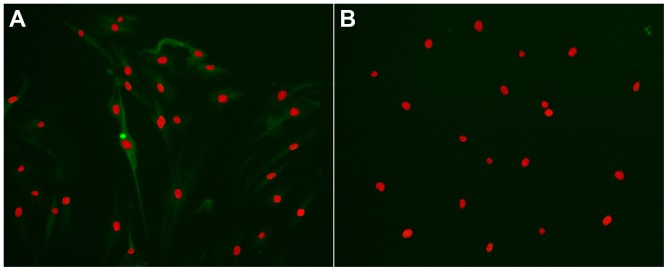
Immunofluorescence identification of human Tenon fibroblasts.Cells were identified by immunofluorescence with vimentin and cytokeratin. Propidium iodide was used as a nuclear counter stain. (A) Immunofluorescence double-labelling of vimentin (green) and the nuclear (red). (B) Cells did not express cytokeratin.